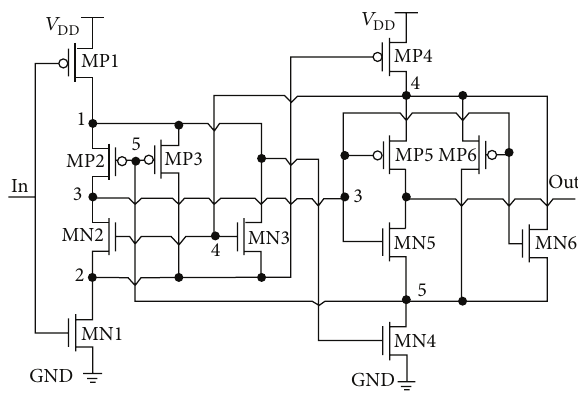
Figure 2: Circuit level model of proposed buffered delay circuit.